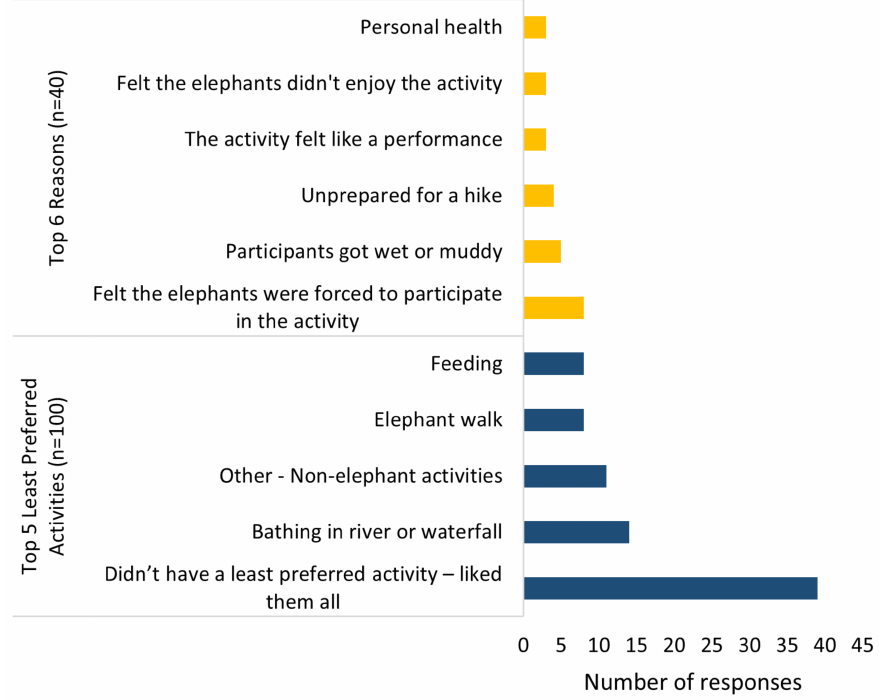
Figure 5. Respondents’ top five least preferred activities ( bottom ) and the top six reasons respondents gave for choosing their least preferred activity ( top ). 147 total activities and 49 total reasons stated (participants could give >1 activity and